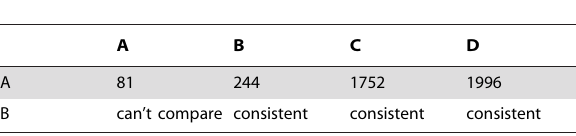
Table 1. Our computation result comparing with Ref. [5].